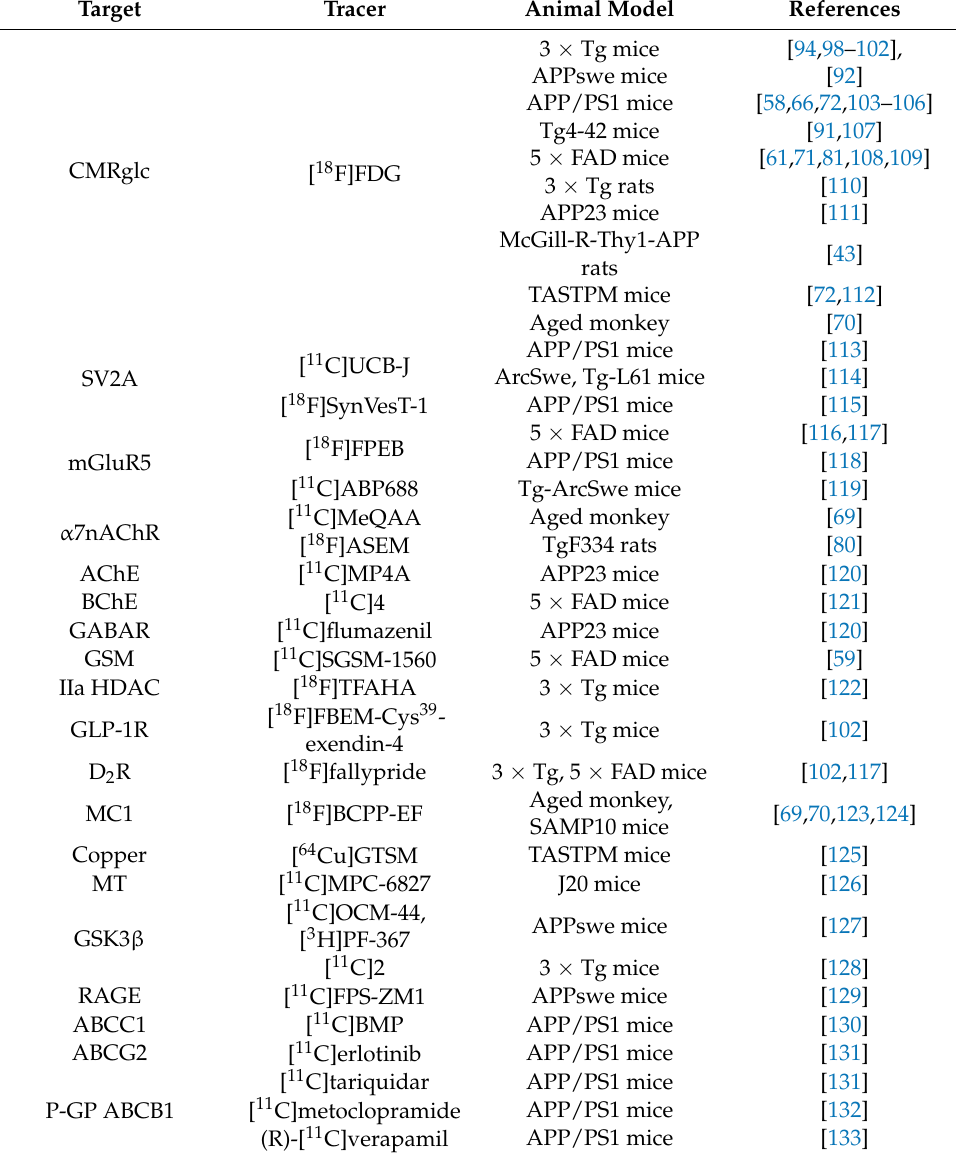
Table 2. PET imaging in of neurotransmitter receptors, blood–brain barriers, enzymes, metabolism, and synaptic density in animal models of Alzheimer’s disease